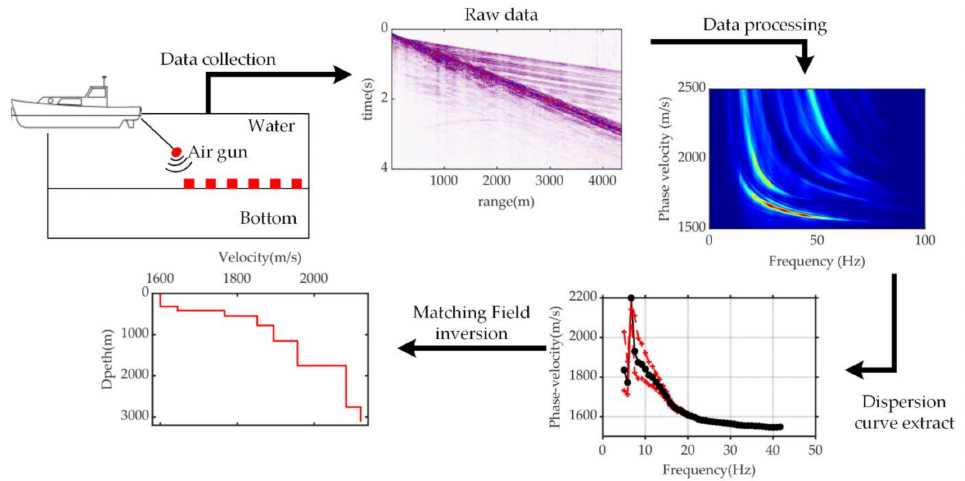
Figure 1. The applicable methodology of underwater